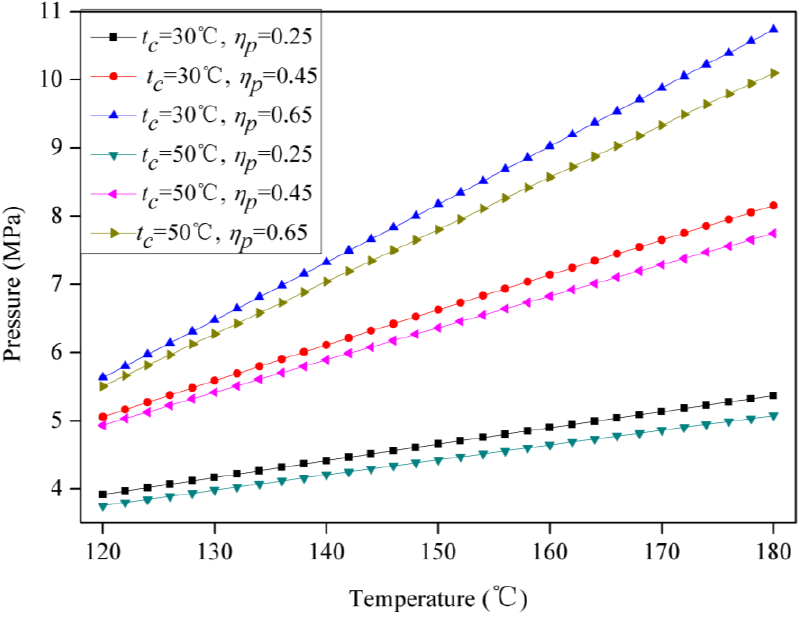
Figure 10. The p - T diagram